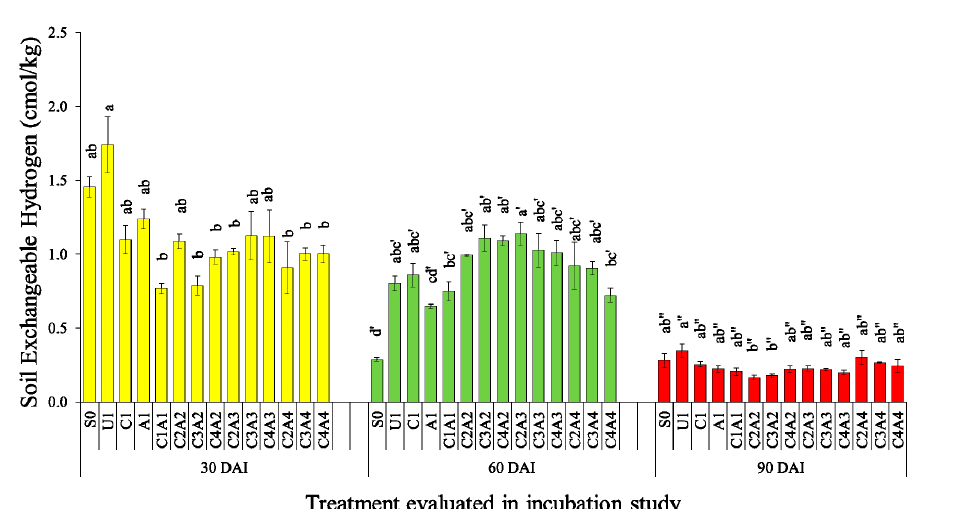
Figure 6. Treatments on soil exchangeable hydrogen ions after thirty, sixty, and ninety days of incubation. Means with different letter(s) within the same incubation period indicate significant difference between treatments by Tukey’s HSD test at p ≤ 0.05. Bars represent the mean values ± SE.